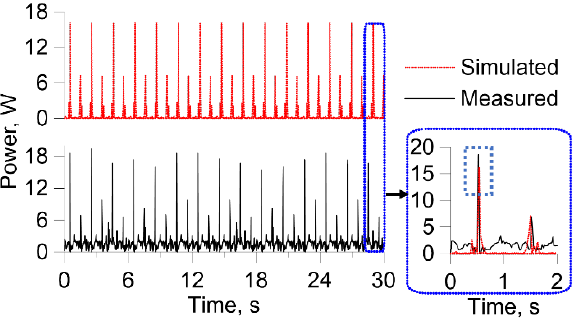
Figure 10. Simulated and measured power consumption of the picking device at 60 rpm condition.